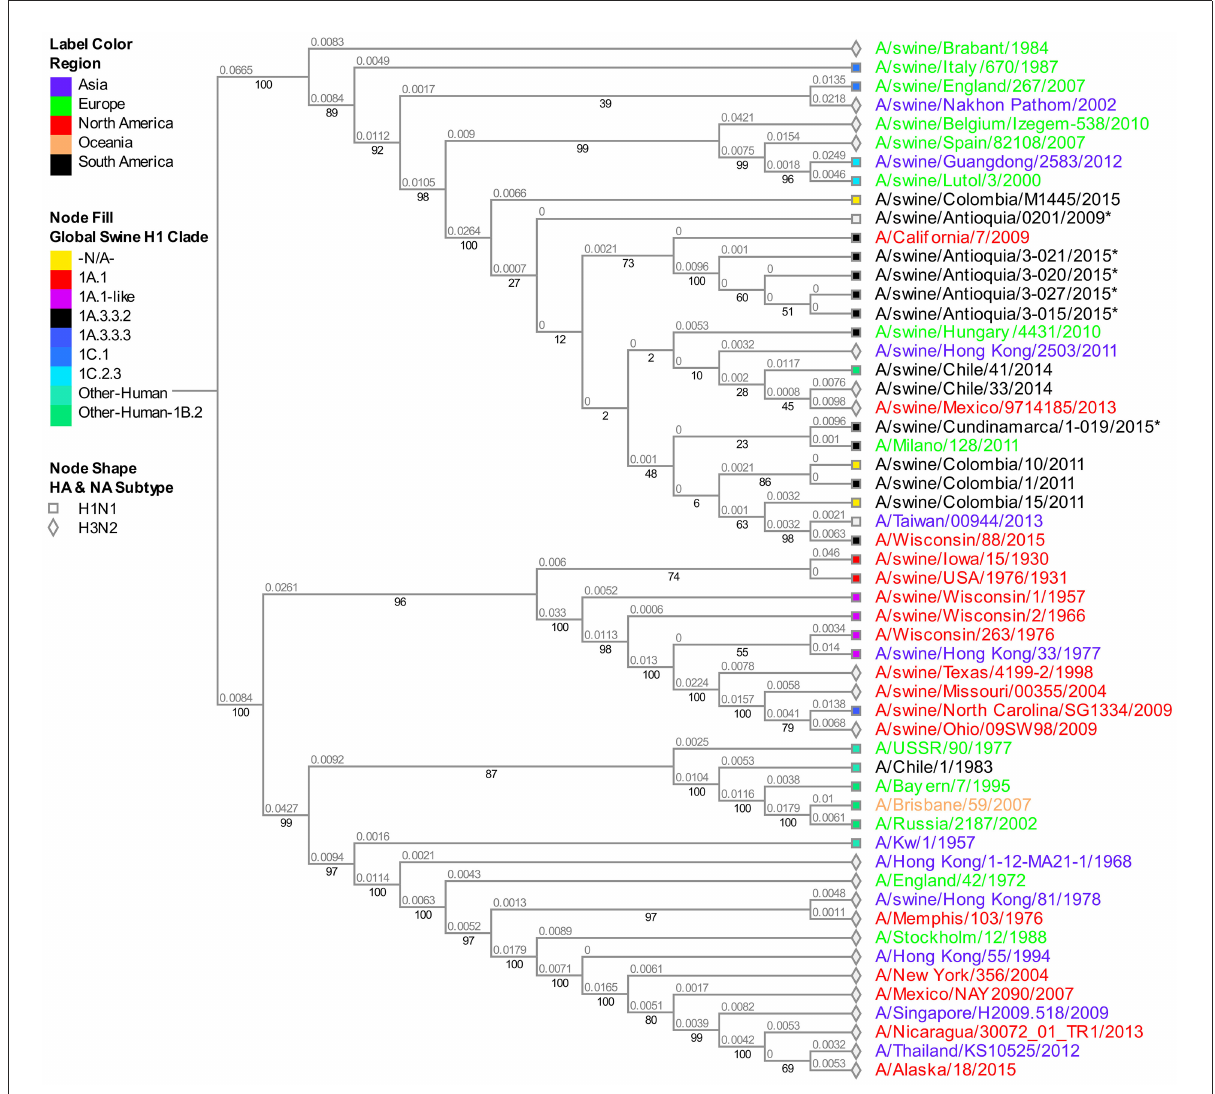
FIGURE3 Phylogenetic analysis for M gene of swine influenza A virus. Phylogenetic tree was generated using RAxML program for maximum likelihood-based inference. The reliability of the trees was inferred by bootstrap analysis with 1,000 replications. The tree was constructed with representative sequences from human and swine H1N1 classical and H1N1pdm09, as well as human and swine H3N2. Colombian isolates included on this study are labeled with